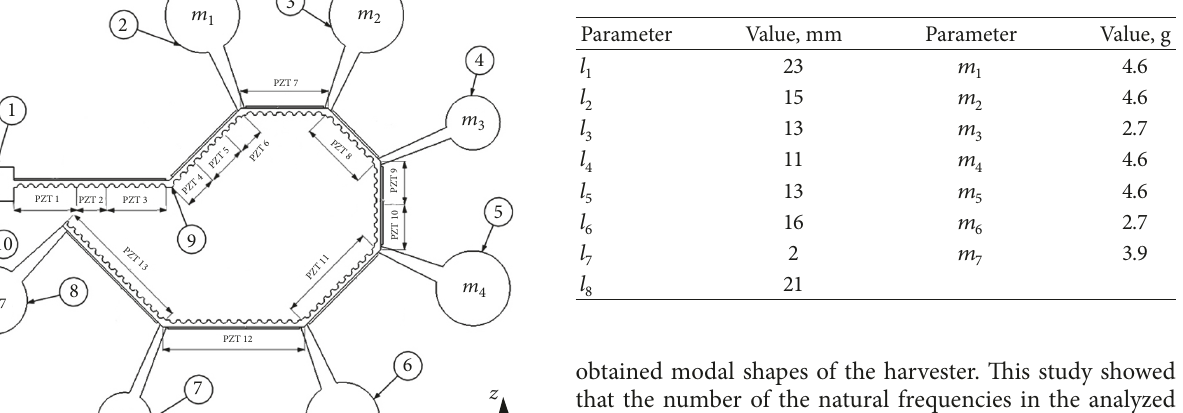
Table 2: Optimized parameters of the